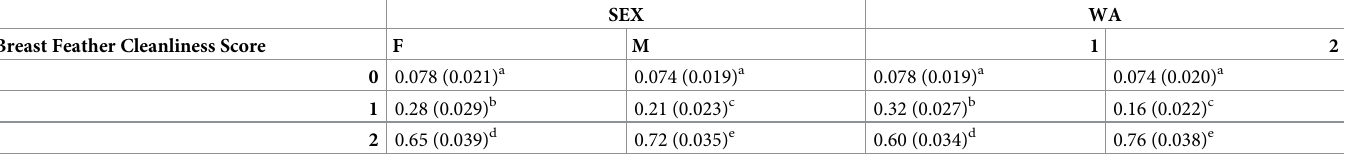
Table 7. The mean proportions of birds (SEM) which had each breast feather cleanliness score for sex and welfare assessment. SEX WA Breast Feather Cleanliness Score F M